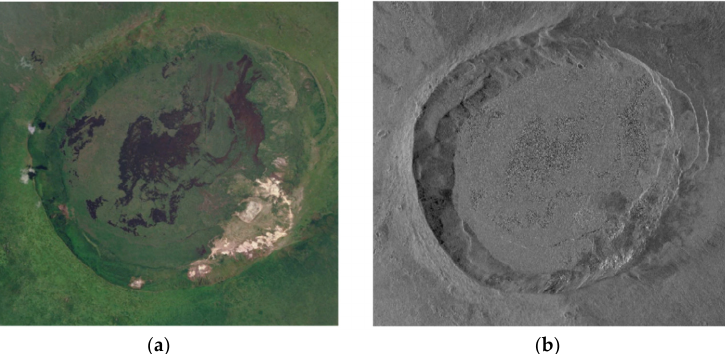
Figure 10. Study area in Volcán Alcedo. ( a ) Optical image from Google Earth. ( b ) Averaged intensity map from 40 SLCs of the Sentinel-1 image stacks.